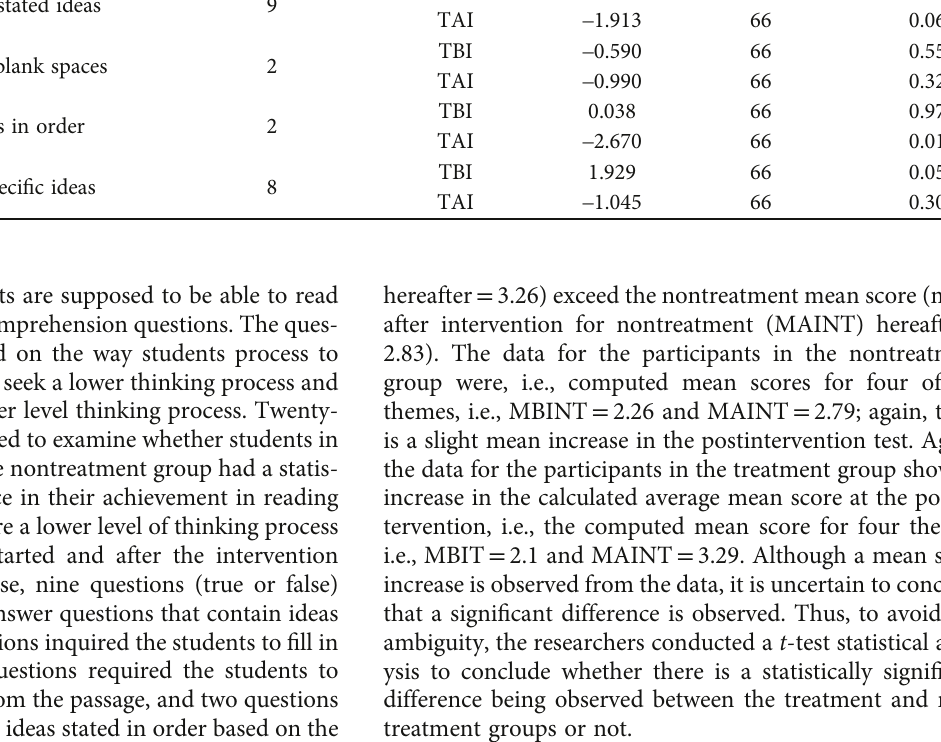
T ABLE 6: Independent samples t -test results for questions on each subskill of reading that requires a lower level of thinking. S.